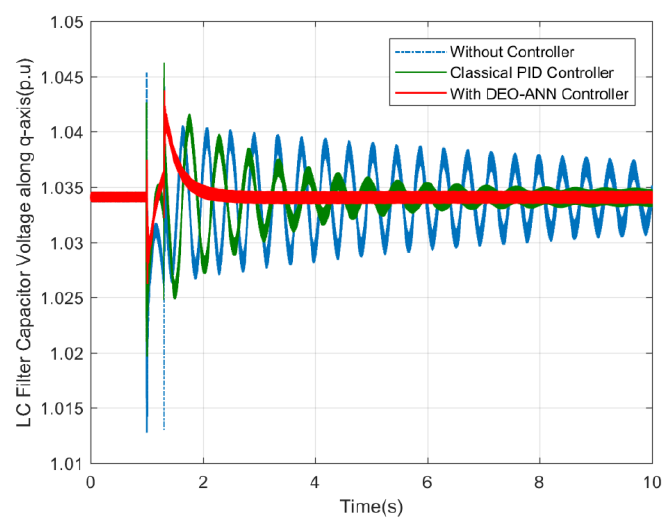
Figure 23. LC filter capacitor voltage along the q-axis.